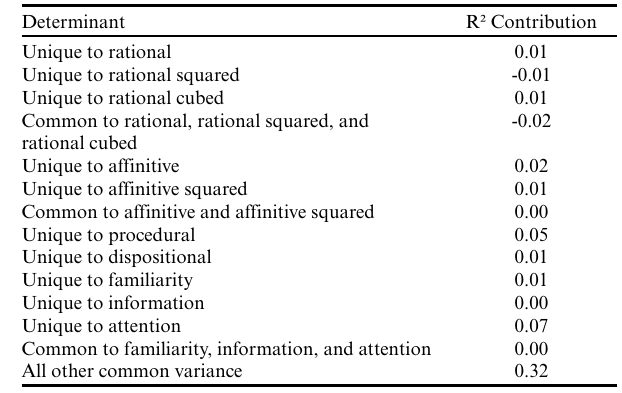
Table 2 . Commonality analysis showing the unique variance explained by the determinants of trust.